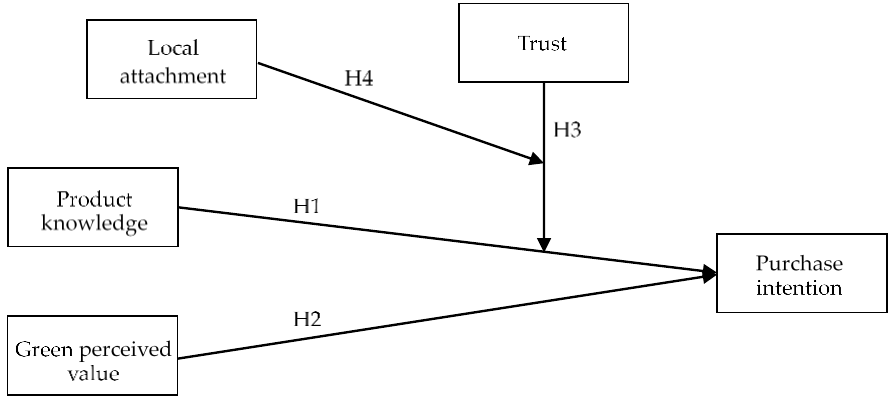
Figure 1. Research Figure 1. Research framework.